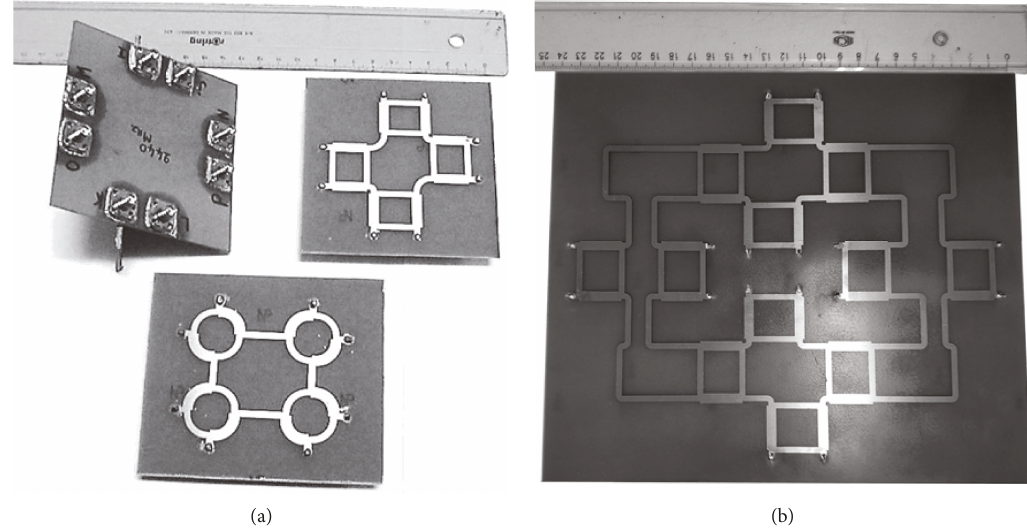
Figure 5: Pictures of certain fabricated prototypes. (a) Top view of the 4 × 4 BMs that correspond to the layouts of Figures 2(b) and 2(c) and bottom view of the layout depicted in Figure 2(b). (b) Top view of the 8 × 8 BM.